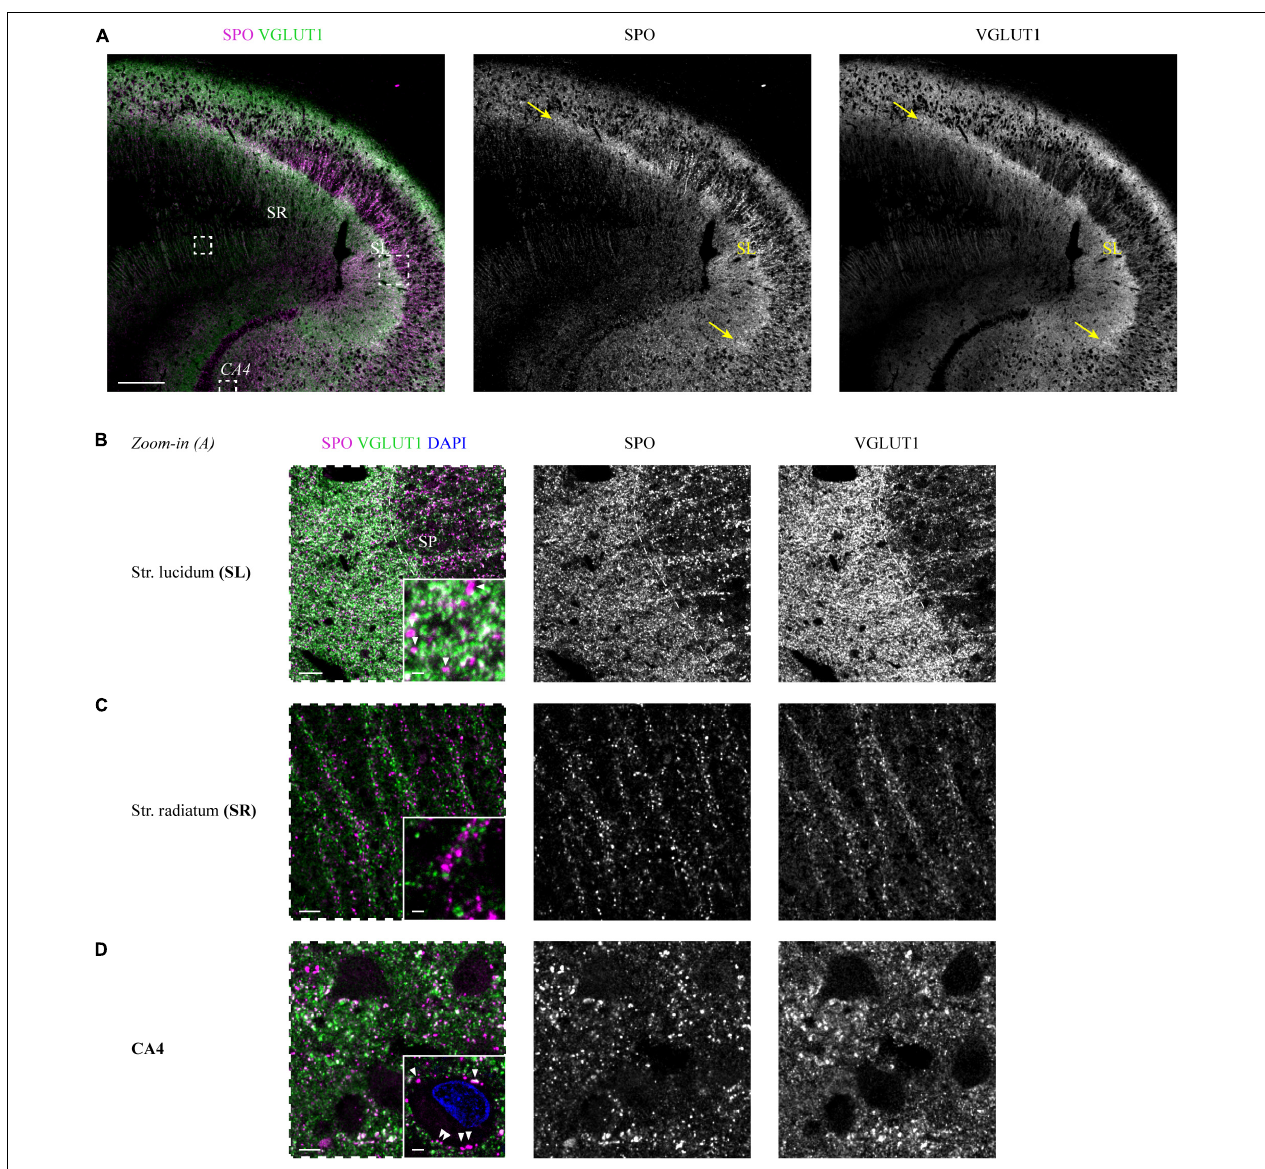
FIGURE 2 | Co-staining of VGLUT1 and the mossy fiber-enriched protein synaptoporin in the human hippocampus. (A) Synaptoporin (SPO, magenta) and VGLUT1 (green) co-staining in a hippocampus section, areas of overlap appear in white (left). Individual channels are shown in the middle (SPO) and right (VGLUT1) column. Dashed squares (white) are shown in higher magnification in panels (B–D) as images with dashed frames. The yellow arrows mark the borders of the stratum lucidum , i.e., CA3. Scale bar, 300 µ m. Zoom-in images of stratum lucidum (B) , stratum radiatum (C) , and CA4 (D) are displayed in the same manner as outlined in panel (A) . Contrast adjustment was performed identically for panels (B–D) . Insets at the lower right of each image represent MIPs of high-resolution z-stacks (z = 1.98 µ m) in the respective layer, imaging parameters and contrast adjustments were kept constant. (B) White arrowheads in the inset mark non-co-localizing SPO puncta. Scale bar overview, 20 µ m; inset, 2 µ m. (C) Scale bar overview, 10 µ m; inset, 2 µ m. (D) White arrowheads in the inset mark perisomatic SPO puncta of a mossy cell in CA4. Scale bar overview, 10 µ m; inset, 3 µ m. Images in panels (A–D) are derived from case